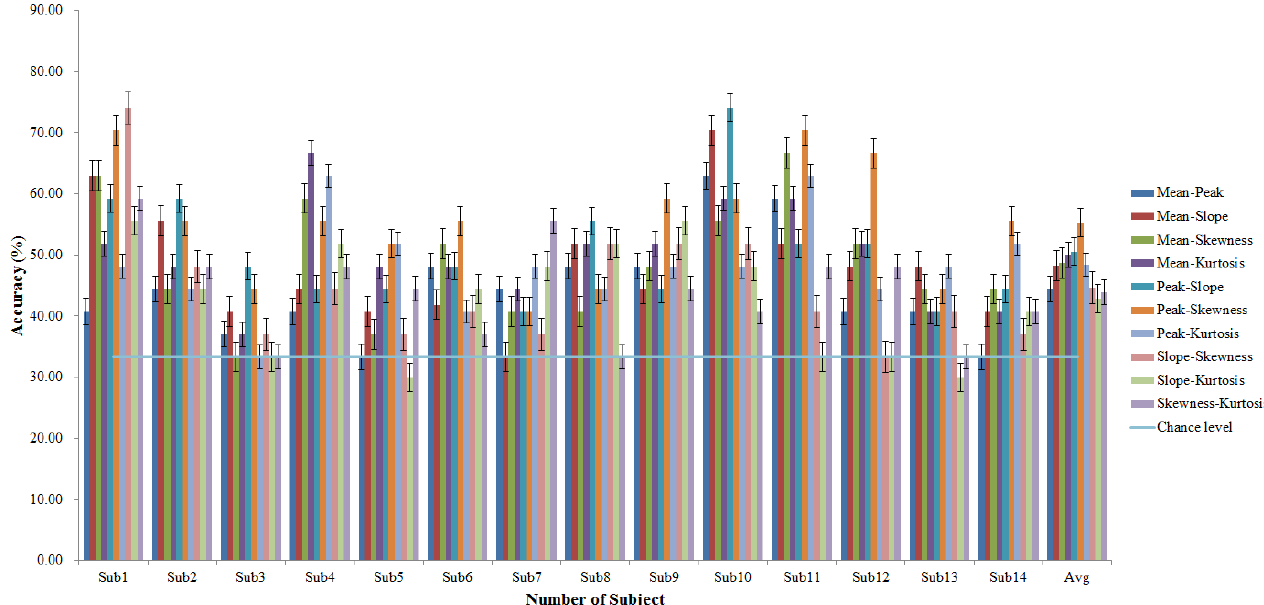
Fig. 6. Classi¯cation accuracies across 14 subjects based on 10 feature-combinations (mean, peak, slope, skewness, and kurtosis).